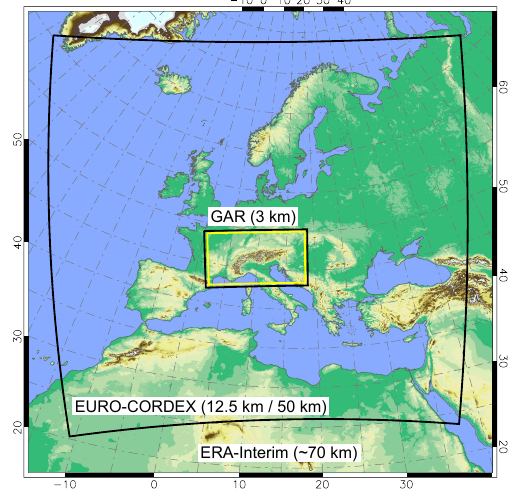
Figure 2. RCM domains. ERA-Interim is dynamically downscaled with CCLM and WRF from its initial resolution of ∼ 70 to 3km in the Greater Alpine Region (GAR) by making use of an intermediate model domain, the EURO-CORDEX domain with 12.5 and 50km grid spacing.